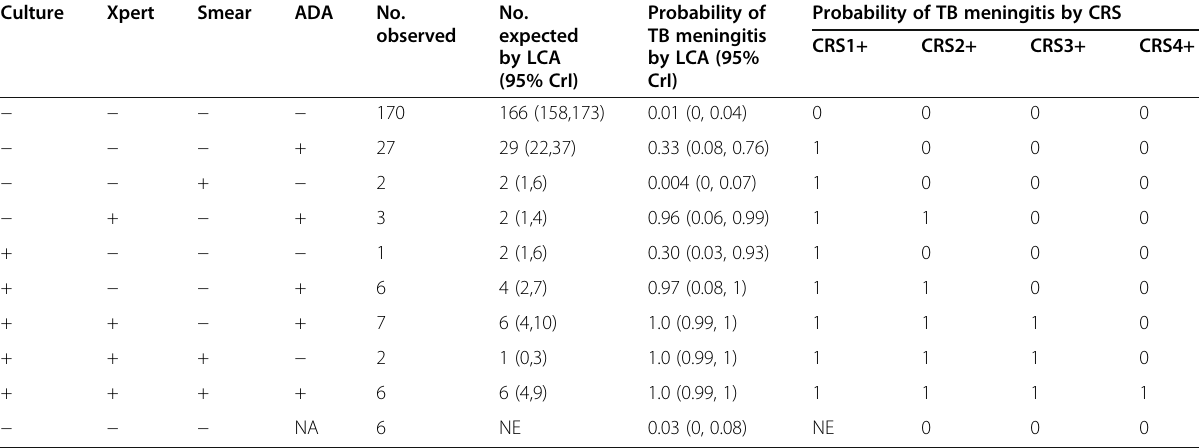
Table 5 Observed counts, expected counts, and TB meningitis probability by test result pattern Culture